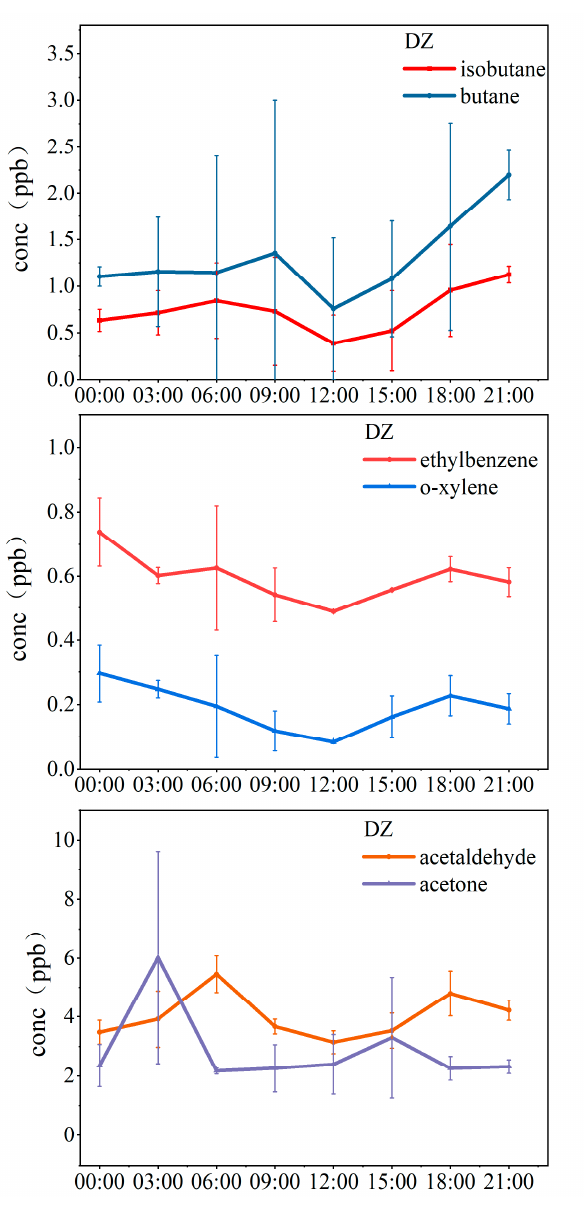
Figure 4. Diurnal variations of VOCs at DZ and SS sites.